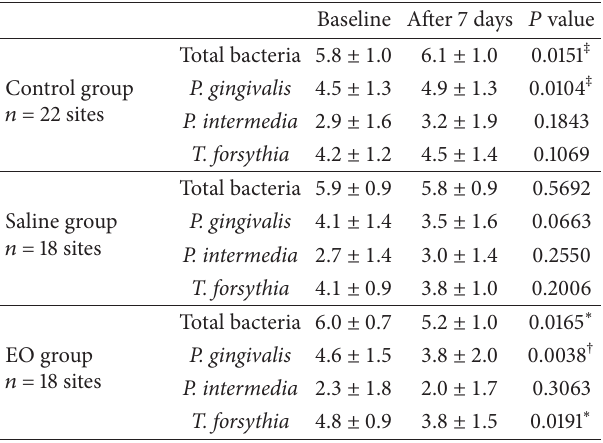
Table 4: Comparison of subgingival bacterial counts in deep pock- ets (PPD ≥